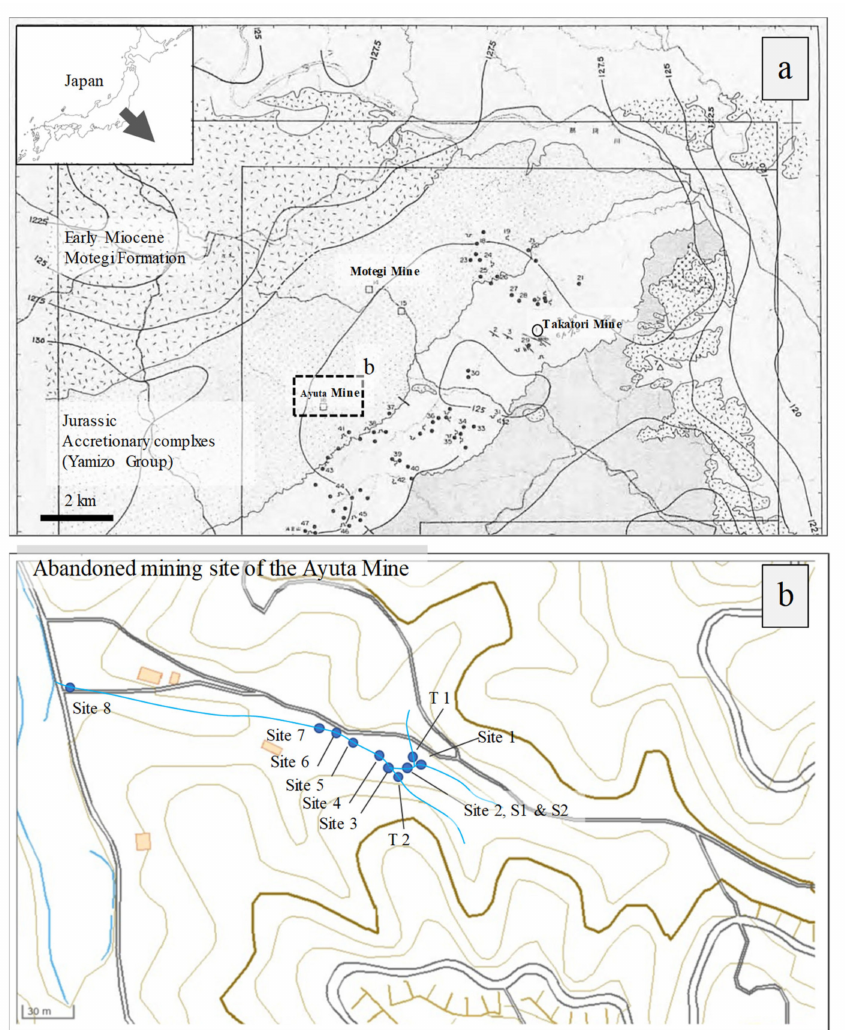
Figure 1. Geology and location of the Ayuta Mine, Tochigi Prefecture, Japan. ( a ) Geologic map. Geological data were compiled from the Metal Mining Agency of Japan [10] and Yoshioka et al. [11]. ( b ) Location map of the “b” position marked in ( a ). The positions of sample sites from 1 to 8 along the stream are plotted on the topographic